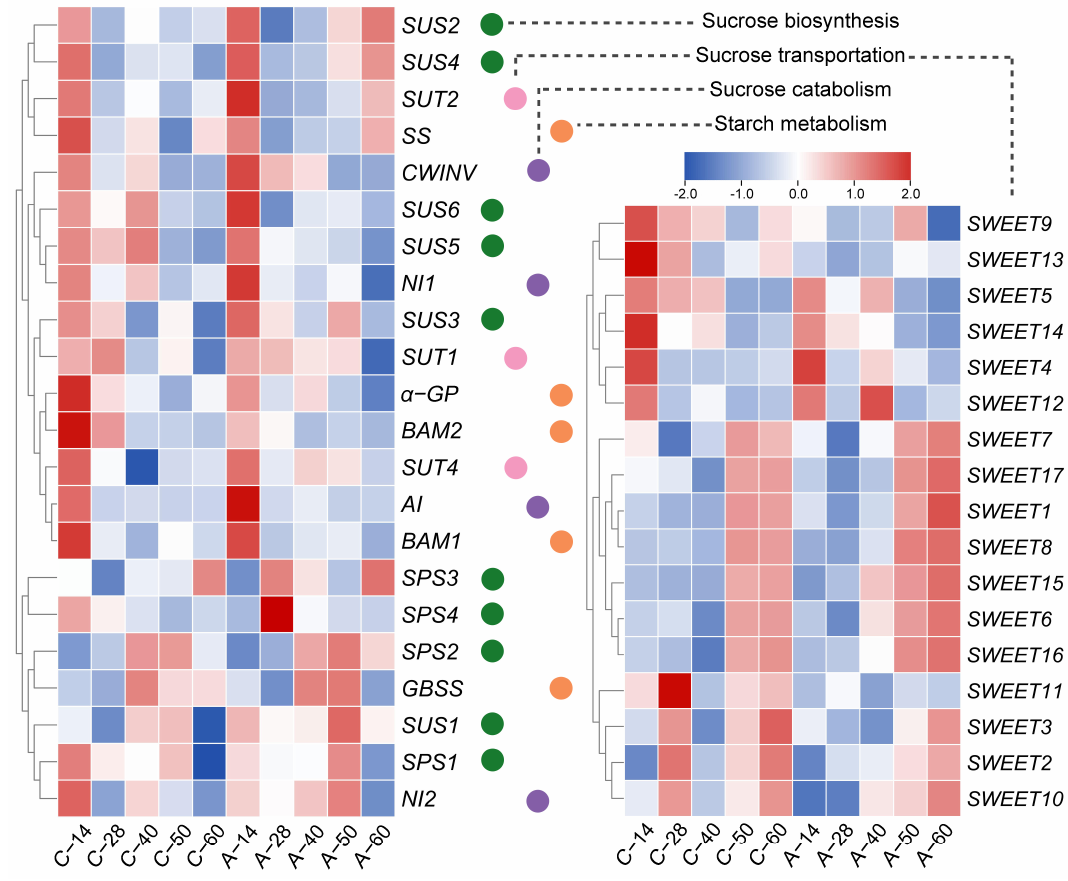
Figure 5. E ff ect of ALA treatment on the relative expressions of the sugar-related genes during nectarine development. C-14 to C-60 and A-14 to A-60 represent the fruit samples collected 14 to 60 days after spraying clear water and ALA, respectively. The color gradient from blue to red corresponds to fold changes from low to high.